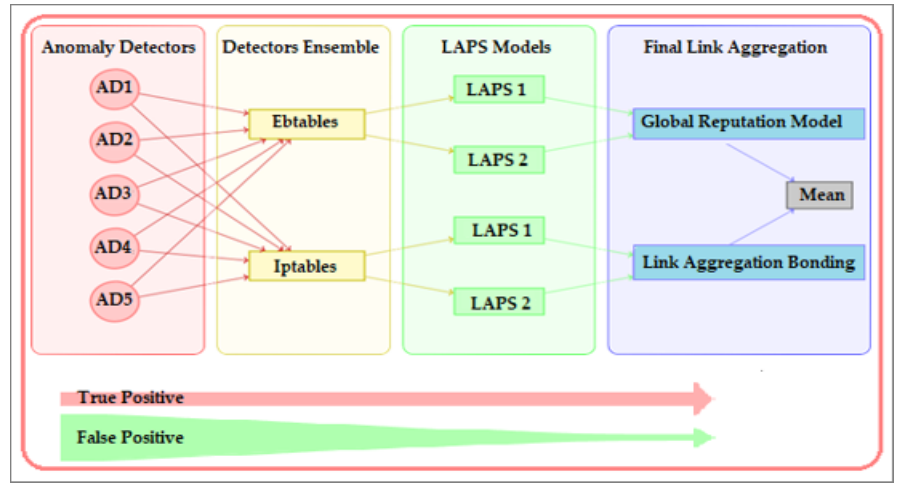
Figure 1. Anomaly processing pipeline architecture. (LAPS: Linux-Availability Protection